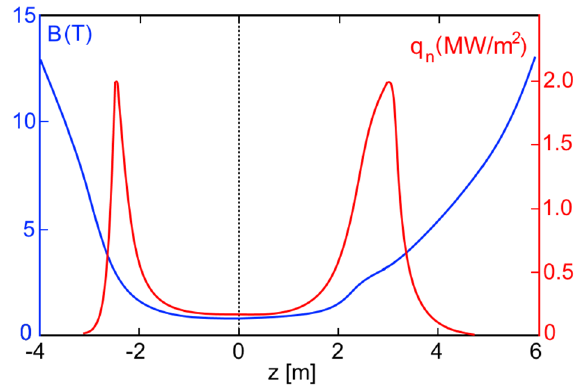
Figure 4. Magnetic field profile (blue, left scale) and neutron flux density profile (red, right scale) in GDT ‐ NS. The electron temperature T e is a very important parameter for a plasma neutron source.